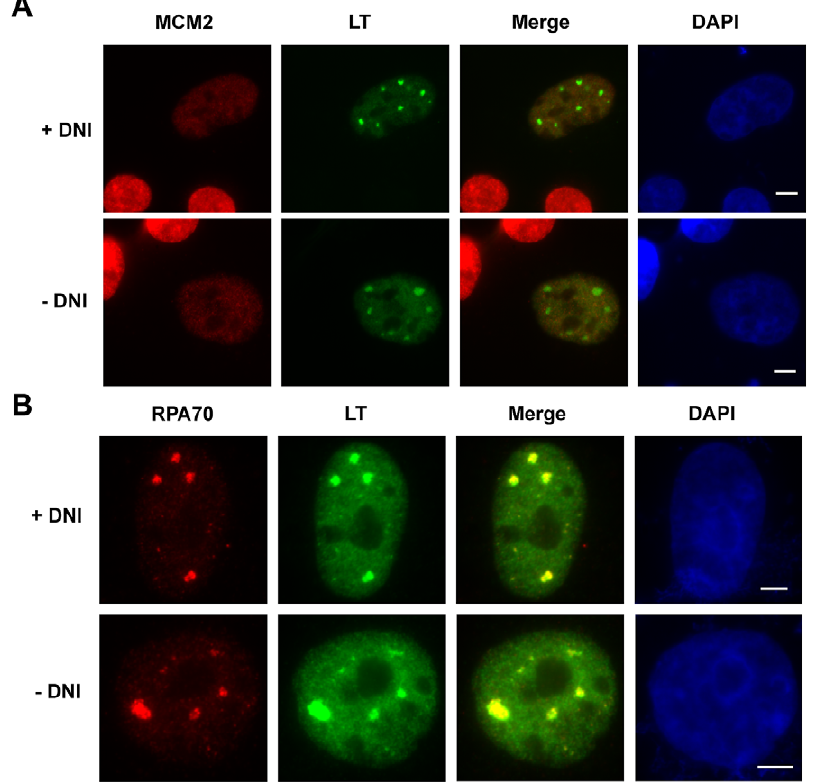
Figure 7. The MCV replication complex. A . The host helicase MCM2 does not co-localize with MCV LT in the MCV replication foci. C33A cells were co-transfected with pcDNA4C-MCV LT and either pcDNA4C-MCV Ori ( 2 DNI) or pcDNA4C-MCV Ori-DNI ( + DNI). Cells were stained using antibodies for MCM2 (Red) and MCV LT (Green). Bar, 5 m m. B . The DNI does not inhibit viral Ori unwinding. C33A cells transfected as in A were stained using antibodies for RPA70 (Red) and MCV LT (Green). Bar, 5 m